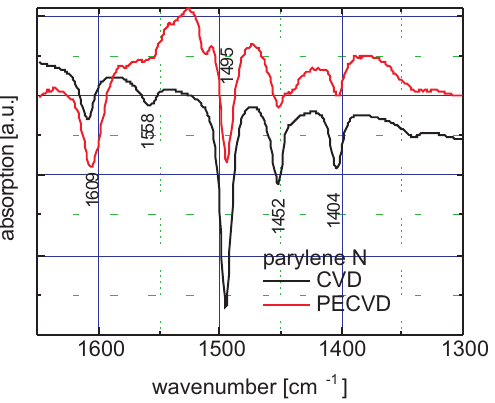
Figure 20. FTIR spectrum between 1650 and 1300 cm − 1 . Applied microwave power is 150 W. Both the layers show the deformation vibrations and ring vibrations ( δ CH 1452 cm − 1 ), ν ring : 1495, 1609 cm − 1 ). The line at 1558 cm − 1 is due to Cl-substitution and consequently do not occur in the